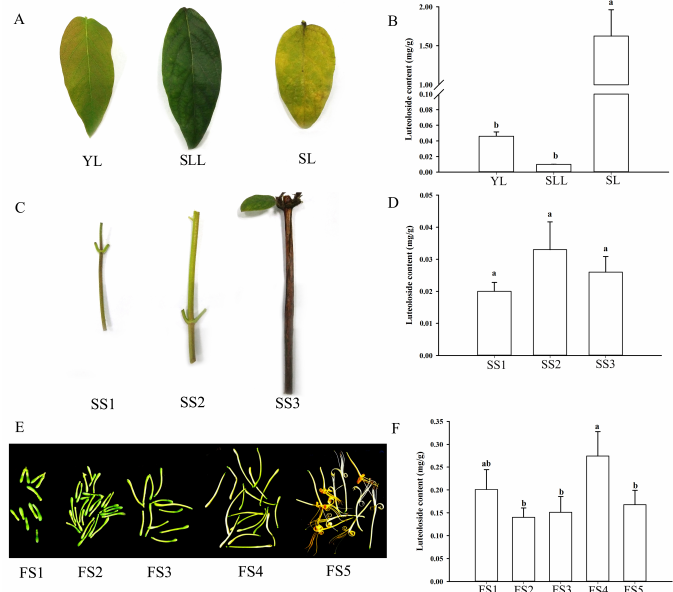
Figure 1. The luteoloside contents in different tissues at different developmental stages in Lonicera macranthoides . ( A ). Leaves at three developmental stages. YL, SLL and SL indicate young leaves, semi-lignified leaves and senescing leaves, respectively. ( B ). Luteoloside contents in leaves were determined by HPLC. ( C ). Stems at three developmental stages. SS1, SS2 and SS3 indicate young stems, semi-lignified stems and senescing stems, respectively. ( D ). Luteoloside contents in stems were determined by HPLC. ( E ). Flowers at five stages of development, including green flower buds in length of 10 mm (FS1) and 20–30 mm (FS2), white flower buds in length of 30–40 mm (FS3), white flower (FS4) and yellow flower (FS5). ( F ). Luteoloside contents in flowers were determined by HPLC. Three biological replications were performed for each examination. Values are means ± SD ( n = 3). Duncan’s multiple range test was used to analyze the significance and the different lower-case letters (e.g., a and b) indicate significant ( p < 0.05) differences between